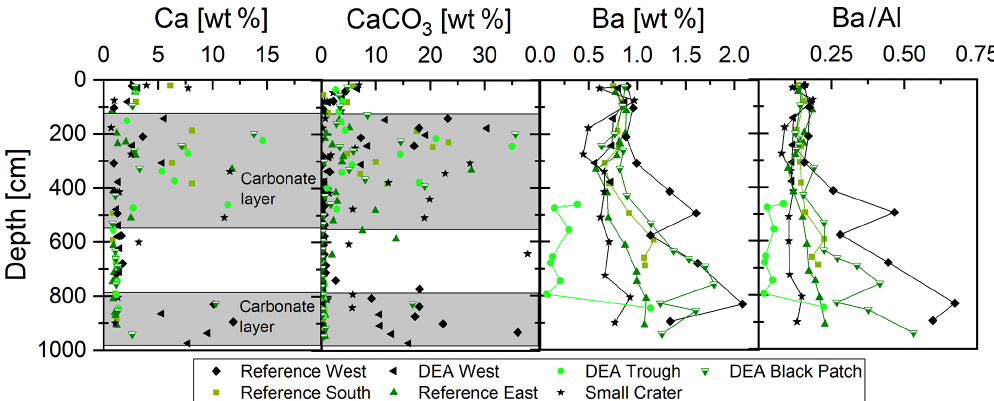
Figure 5. Depth profiles of solid-phase Ca, CaCO 3 , and Ba concentrations, as well as Ba / Al ratios. Core intervals with higher contents of preserved carbonate are shaded in